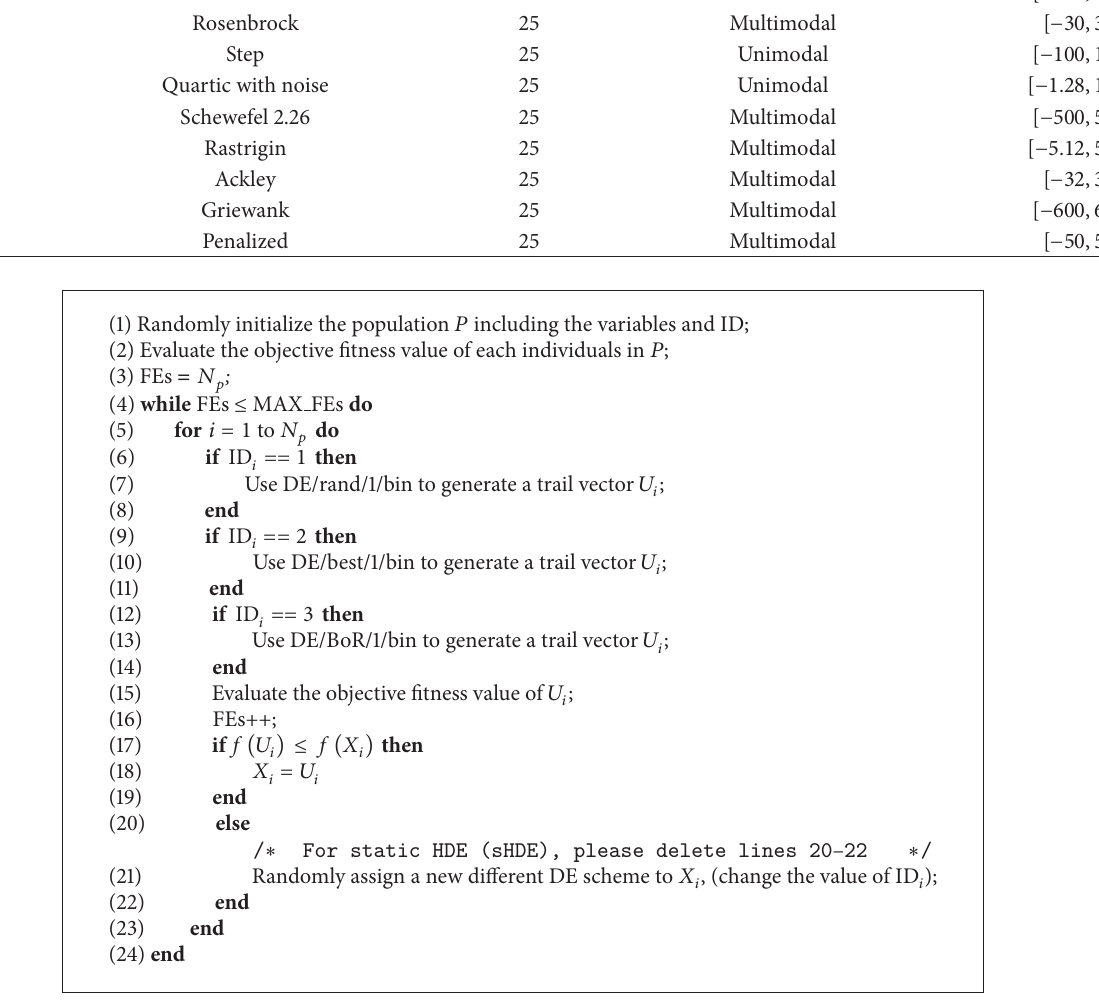
Algorithm 1: The dynamic heterogeneous DE